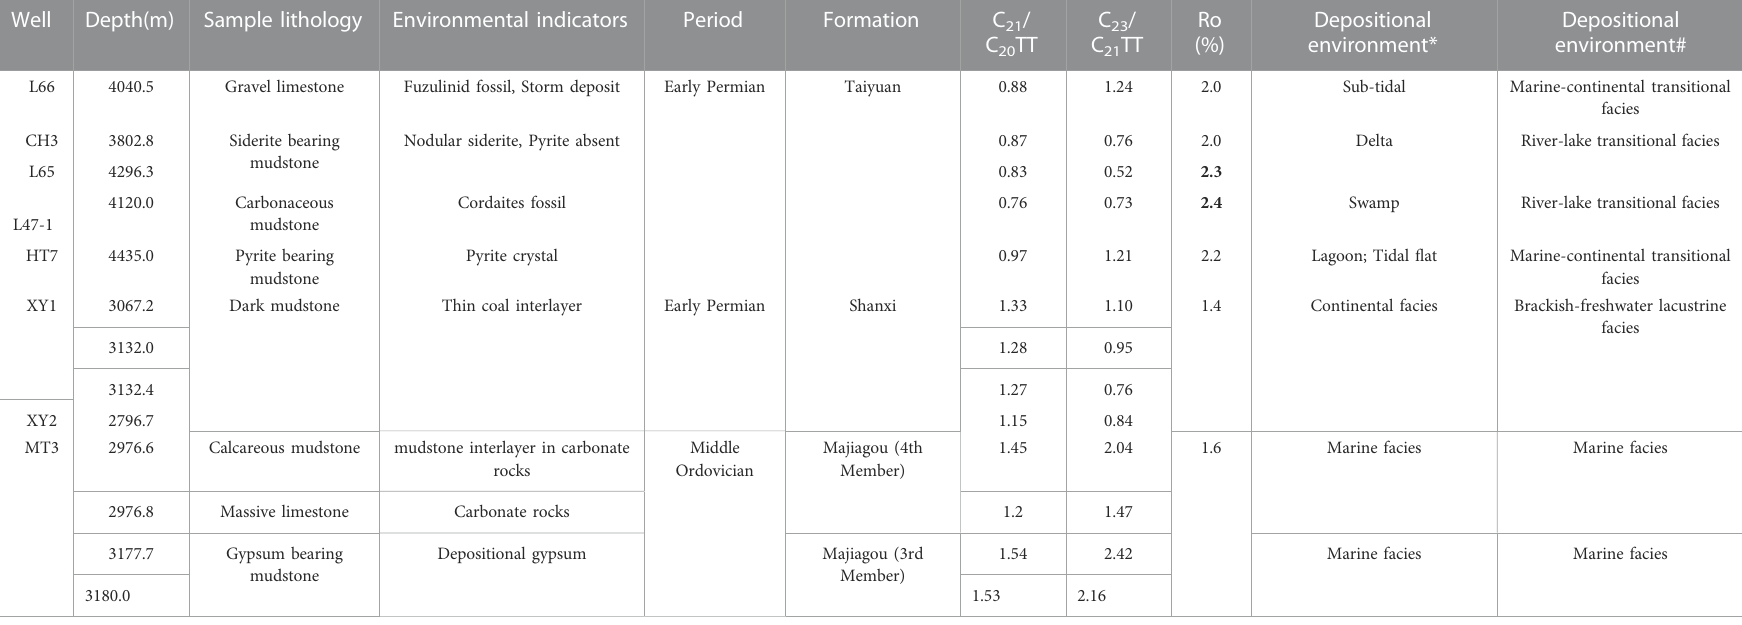
TABLE 2 The ratios of C 21 /C 20 TT, C 23 /C 21 TT and vitrinite re fl ectance (Ro) from the known depositional environments in the Ordos Basin. Well